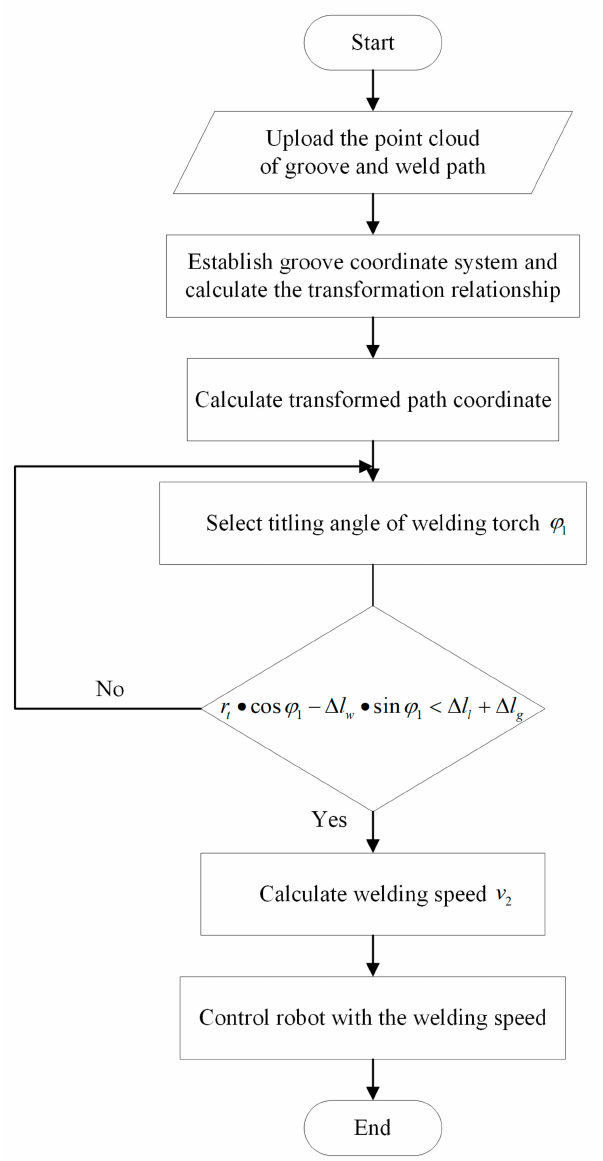
Figure 7. Welding planning flow chart using the proposed